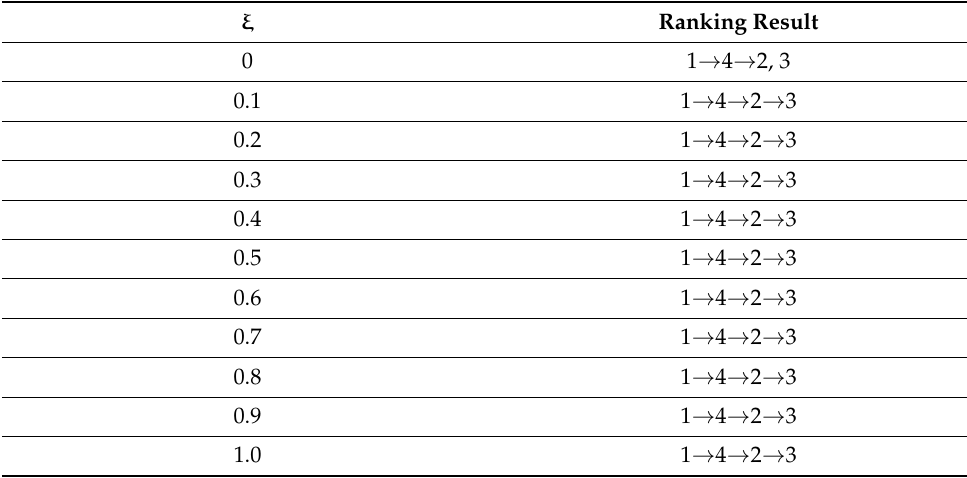
Table 9. Results of the parametric